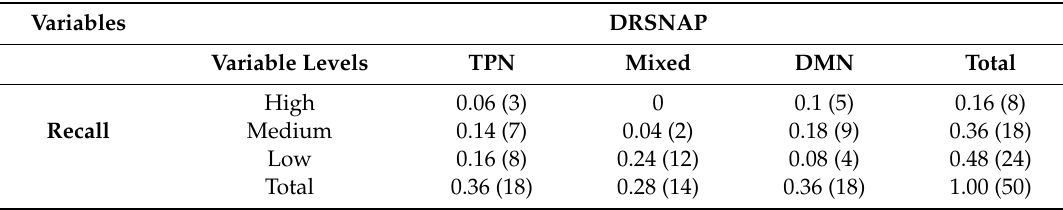
Figure 3. Percentage of words recalled in relation to the dominant resting state network activation pattern. Table 4. Proportions and (total counts) of noun-cues recalled at three di ff erent types of resting state network action